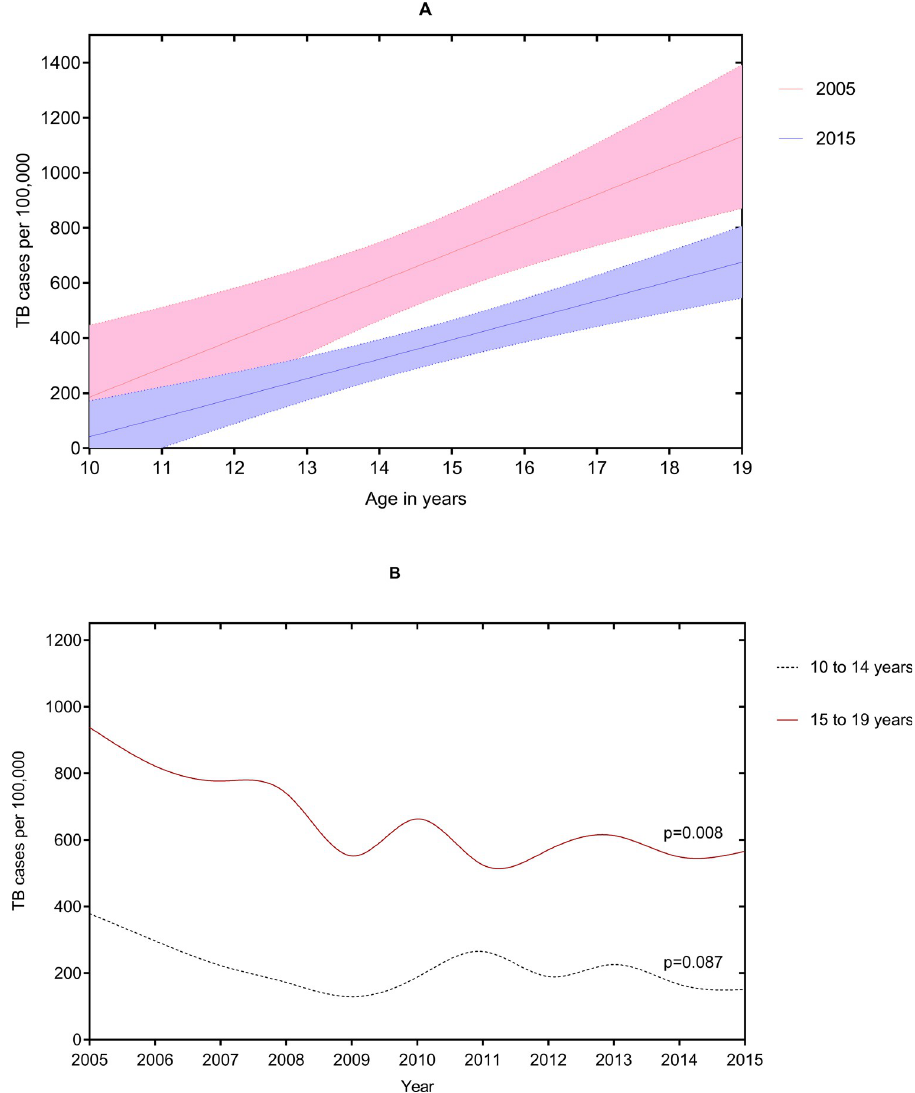
Fig 3. Adolescent TB temporal trends by age and year. Legend: TB = Tuberculosis disease (all–TB). Panel 3A. Adolescent TB disease rates by age and year. Between 2005–2015, TB rates declined by 63% (from 429 to 157 per 100,000; p–value for temporal trend (p–value) = 0 � 350) among adolescents aged 10 years old; by 29% (from 560 to 400 per 100,000; p–value = 0 � 640 among adolescents aged 15 years old; and by 40% (from 1120 to 677 per 100,000; p– value = 0 � 020) among adolescents aged 19 years old. Panel 3B. Adolescent TB disease rates by five–year age groups. TB rates declined by 60% (from 379 to 151 per 100,000) among adolescents aged 10–14 years old; and by 40% (from 938 to 566 per 100,000) among adolescents aged 15–19 years old. P–value is for temporal trend between 2005–2015.